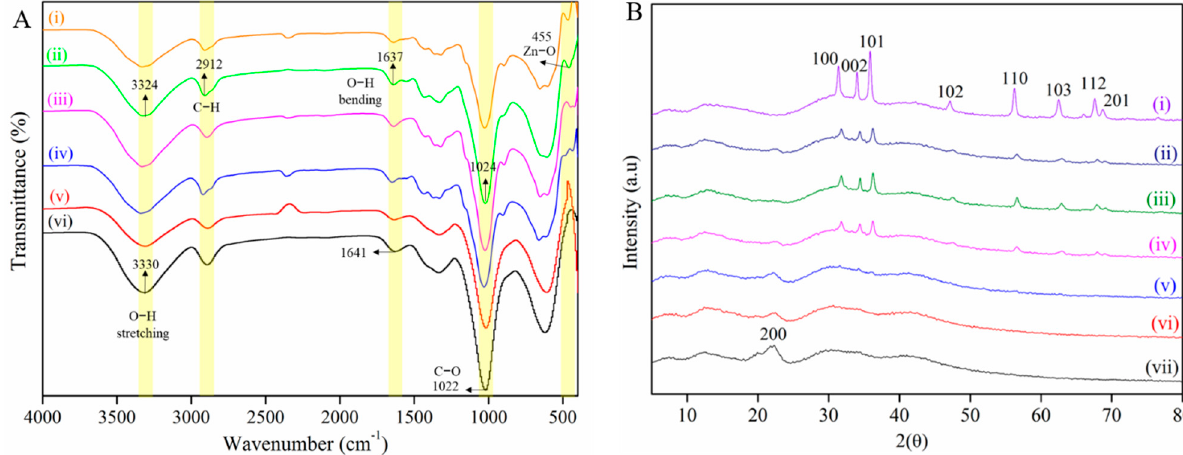
Figure 3. FTIR spectra ( A ) for (i) CNF-ZnO pH 12, (ii) CNF-ZnO pH 10, (iii) CNF-ZnO pH 8, (iv) CNF-ZnO pH 6, (v) CNF-ZnO pH 4, and (vi) pure CNF; ( B ) XRD diffractograms for (i) ZnO NP, (ii) CNF-ZnO pH 12, (iii) CNF-ZnO pH 10, (iv) CNF-ZnO pH 8, (v) CNF-ZnO pH 6, (vi) CNF-ZnO pH 4, and (vii) pure CNF.